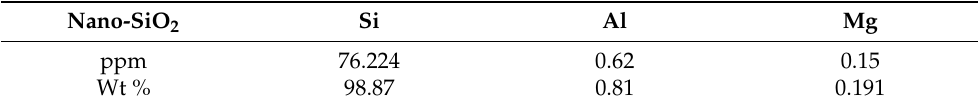
Figure 2. The particle size distribution of nano-SiO 2 (tested by laser diffraction particle size analyzer) (The red line is the particle size distribution curve, and the blue line is the cumulative particle size curve). Table 2. The concentration and purity of nano-SiO 2 . Table 1. The D 10 , D 50 , D 90 of nano-SiO 2 .